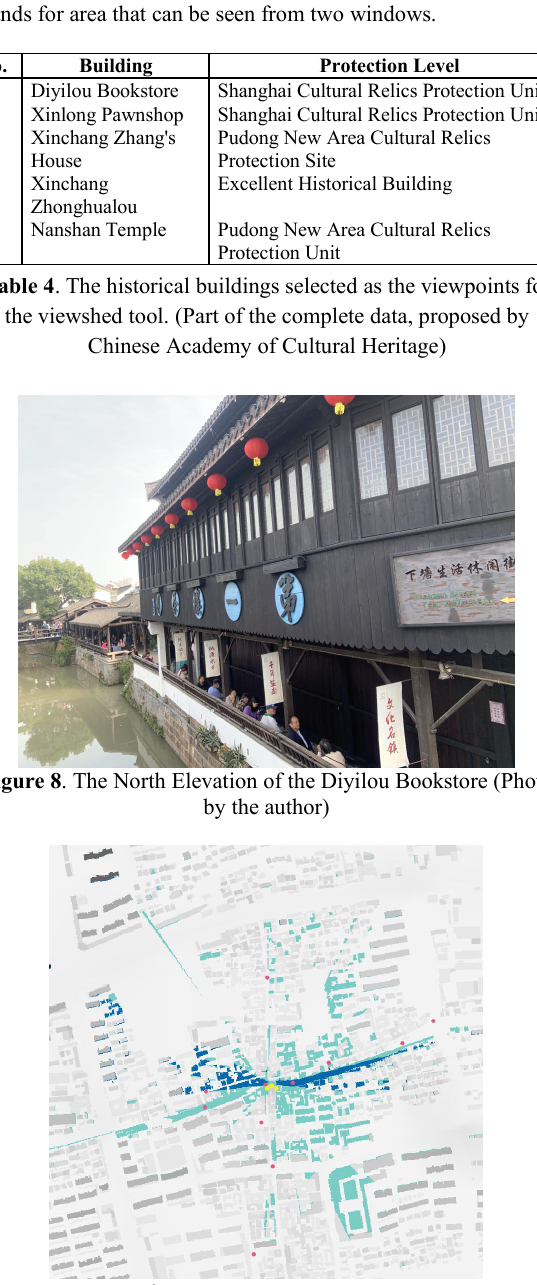
Table 4 . Landscape corridors and nodes selected as